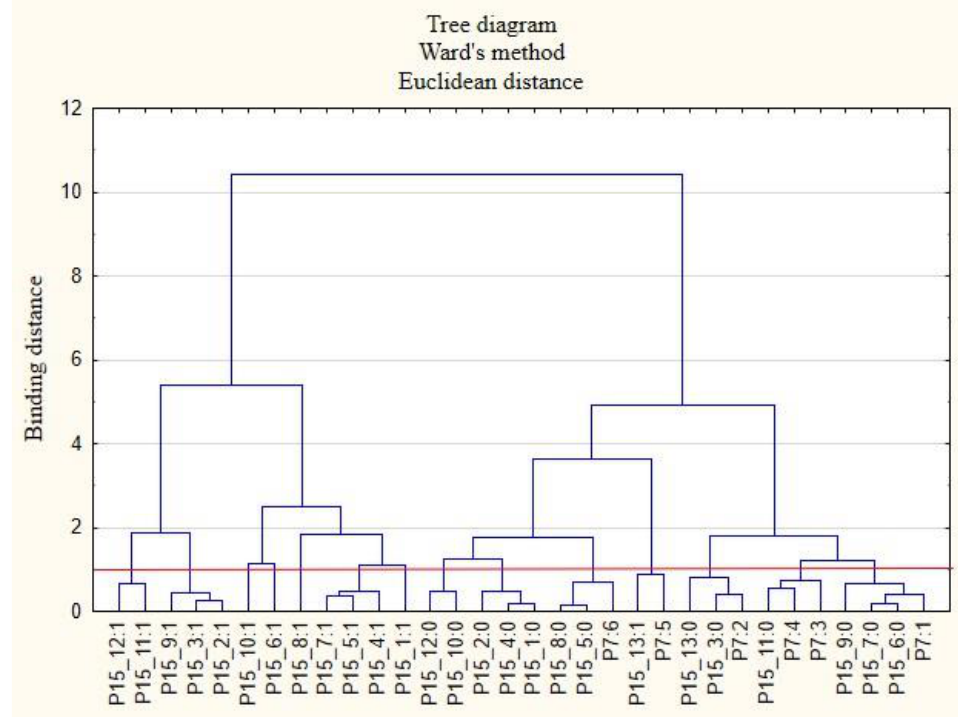
Figure 6. Diagram of hierarchical classification of variable categories support received during the COVID-19 pandemic from the employer in the area of healthcare and effective use of the benefits offered (P15) as well as the forms of employment of the respondents (P7).